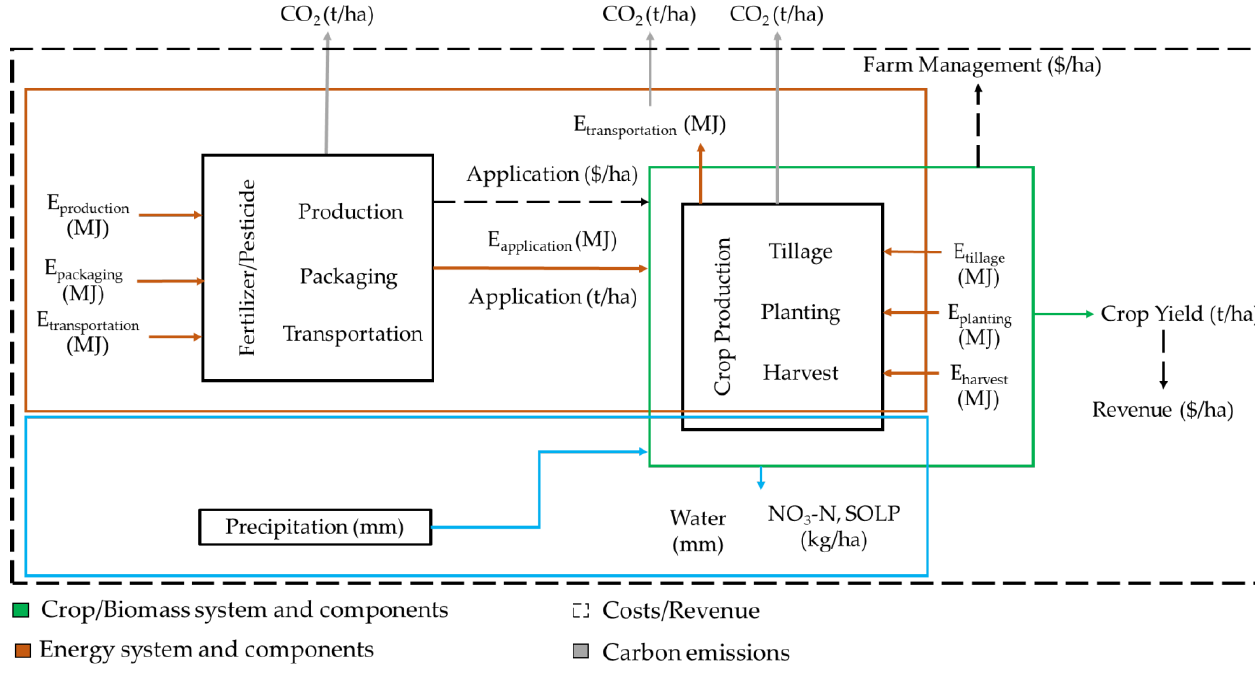
Figure 1. Topography, land cover (2011), and soil drainage classification of the Matson Ditch Watershed, Dekalb County, IN, USA.